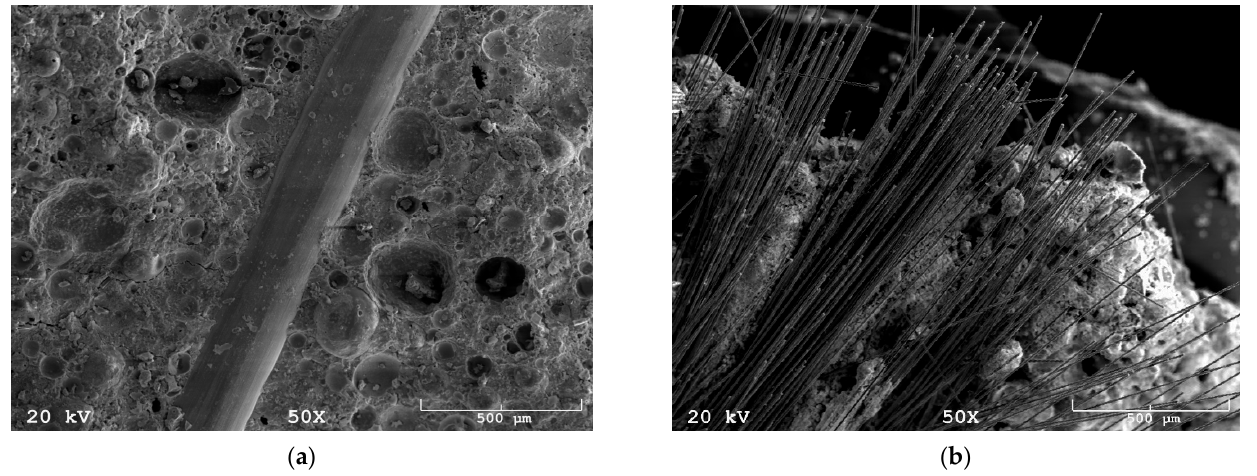
Figure 7. ( a ) SEM image: steel fiber in geopolymer matrix, magnification 50×; ( b ) SEM image: carbon fibers in geopolymer matrix, magnification 50×.